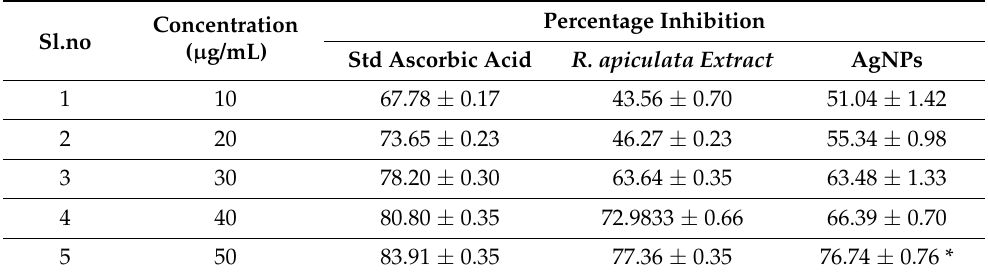
Table 4. DPPH assay of aqueous leaf extract of R. apiculata and its synthesized AgNPs.